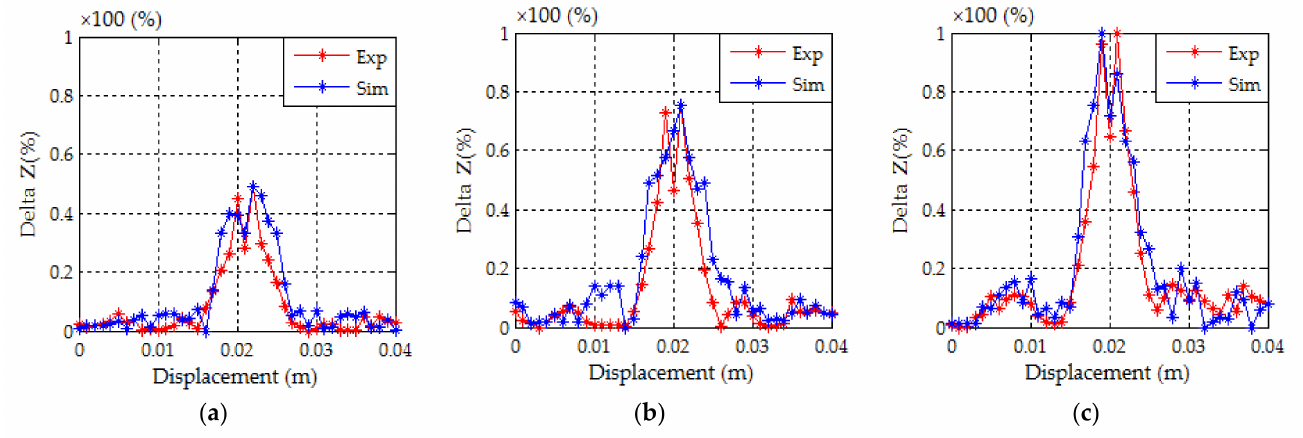
Figure 15. Impedance variation in (%) at 40 kHz with ( a ) depth = 0.3 mm, ( b ) depth = 0.5 mm, and ( c ) depth = 1 mm.